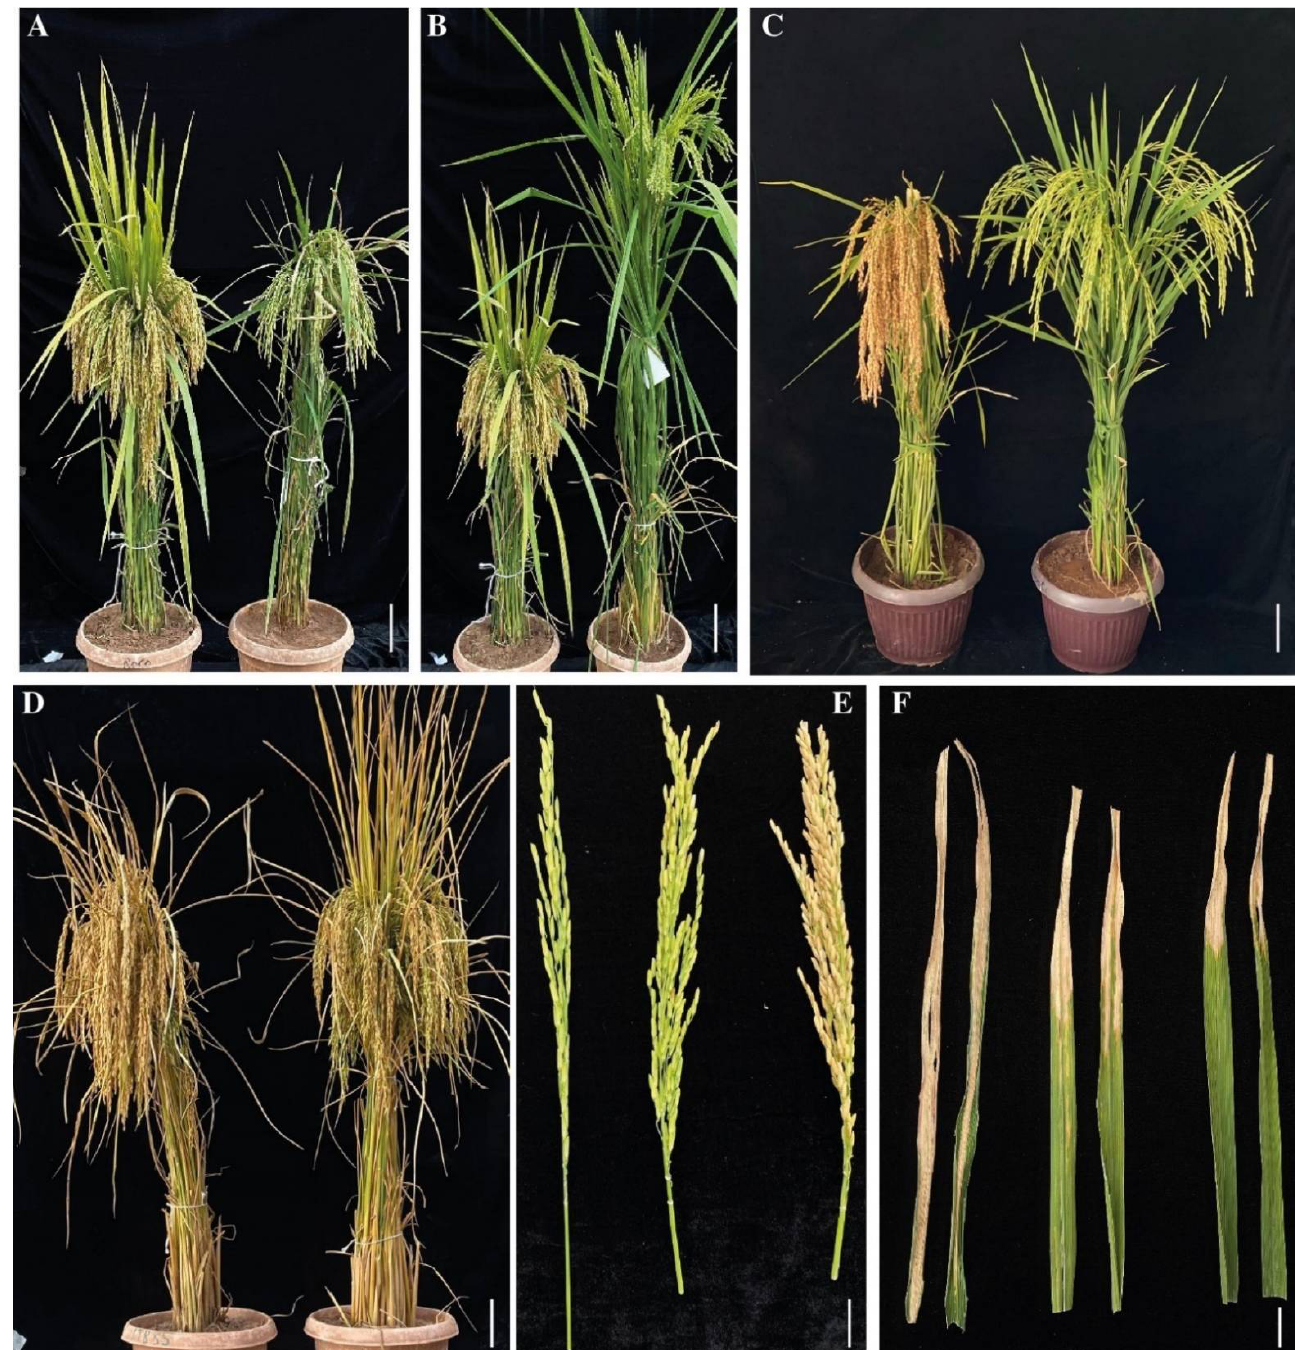
Figure 9. Salient features of GSR traits over BASMATI rice: ( A ) Architecture, left-side plant is GSR and right-side plant is BASMATI, scale = 10 cm; ( B ) Stature, short BASMATI plant vs. long GSR plant, scale = 10 cm; ( C ) Maturity, early maturing GSR plant vs. late maturing BASMATI plant, scale = 10 cm; ( D ) Tillering, left-side plant is BASMATI and right-side plant is GSR, scale = 10 cm; ( E ) Panicle density, left-side plant is BASMATI, center and right-side plant are GSR, scale = 1 cm; ( F ) Bacterial blight disease, left-side plant is BASMATI, center and right-side plant are GSR, scale = 1 cm.